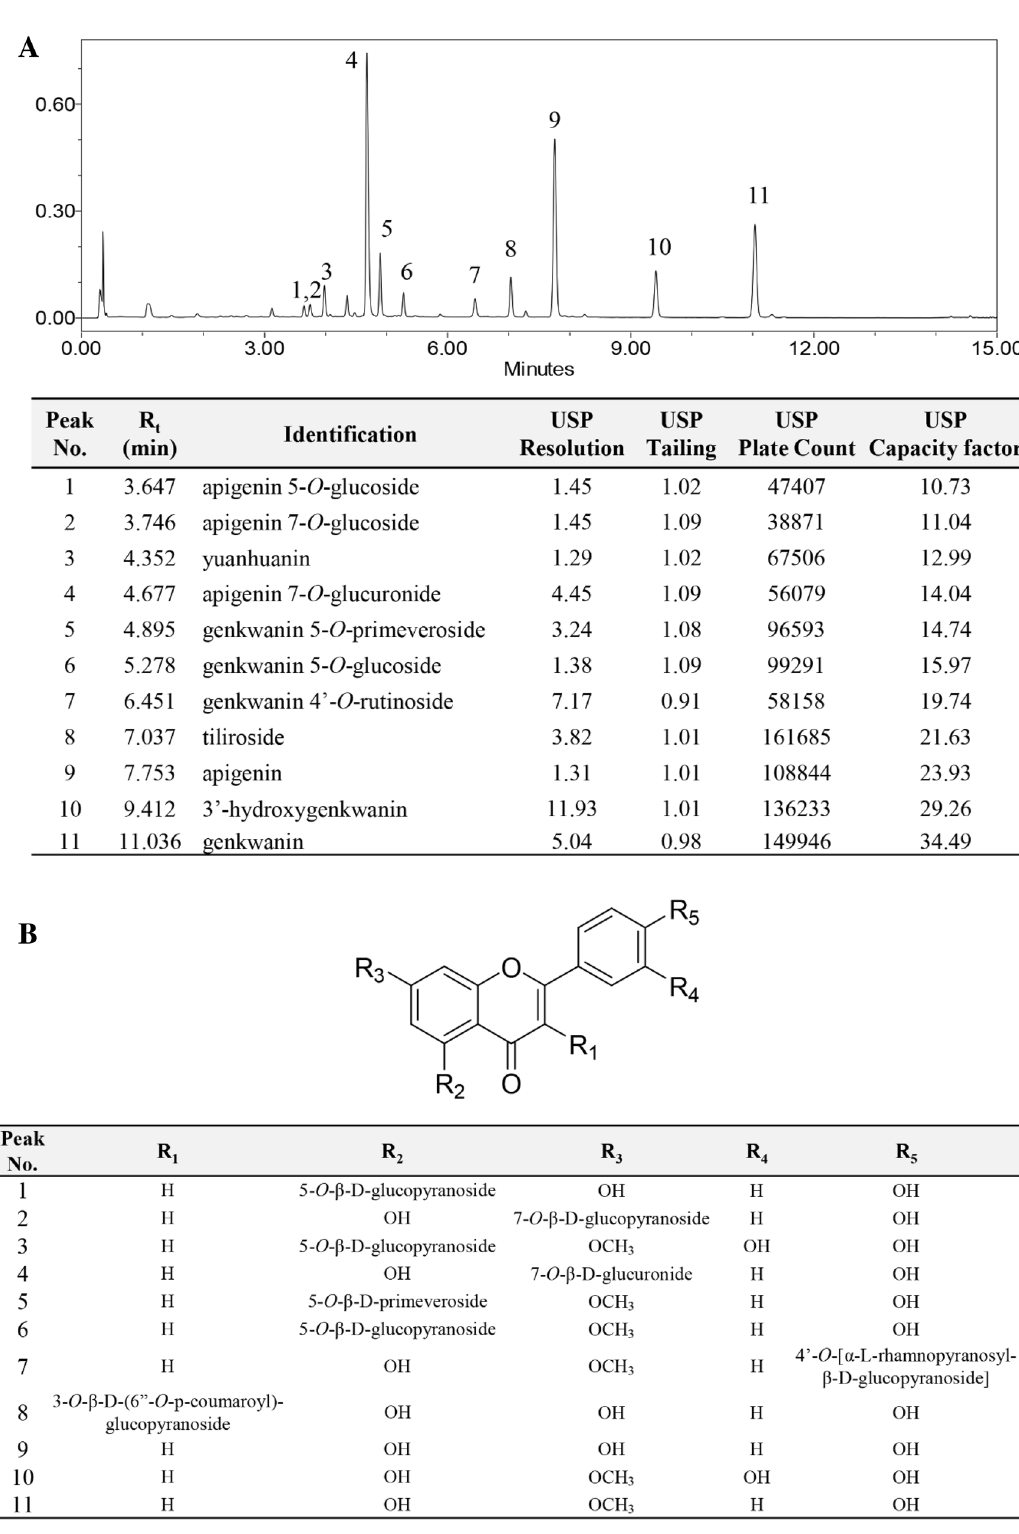
Figure 1. Representative UHPLC chromatogram of Genkwa Flos extract tagged with characteristic 11 flavonoid peaks ( A ) and their chemical structures ( B ). Kinetex-C 18 50× 2.1 mm, 1.7 μm column; mobile phase-A: 0.1% formic acid in water, mobile phase-B: acetonitrile; 335 nm detection; column temperature 28 ℃ ; 0.35 mL/min; gradient Time (min):%B, 0:10, 13:45, 13.5:100, 14:10, 15:10 used for the